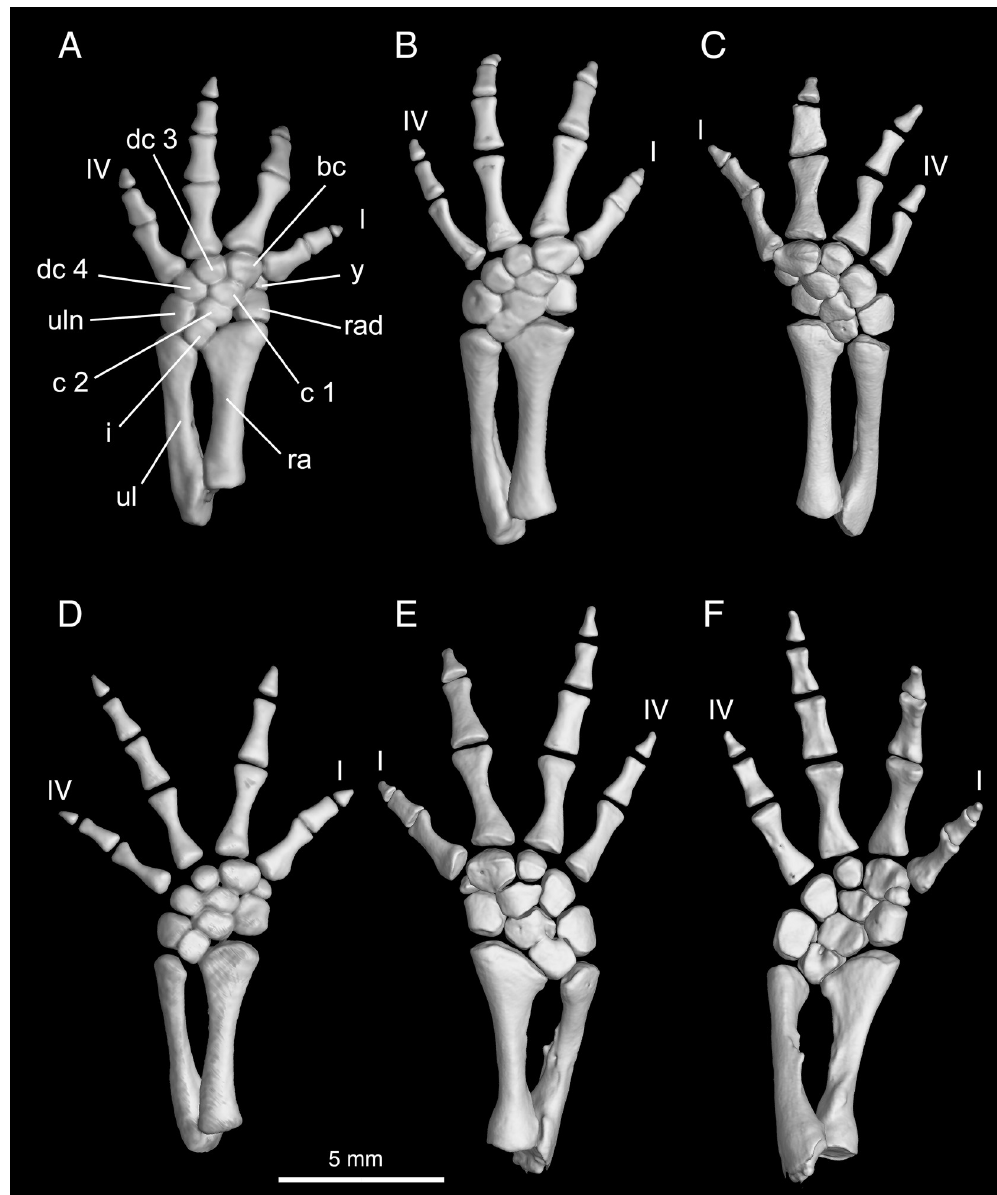
Fig 10. Micro-CT rendered reconstructions of the forearm and manus of Batrachuperus yenyuanensis . Left forearm and manus of CIB 94631(A), CIB 17313 (B), CIB 72596 (D) in lateral view; right forearm and manus of FMNH 49371 (C) and CIB 17308 (E) in dorsal and lateral views; right forearm and manus of CIB 17308 in ventral and medial views (F). FMNH 49371, CIB 17308 and CIB 17313 from Shuangertang, Yanyuan County; CIB 72596 from Tuowu, Mianning County; CIB 94631 from Xieka, Jiulong